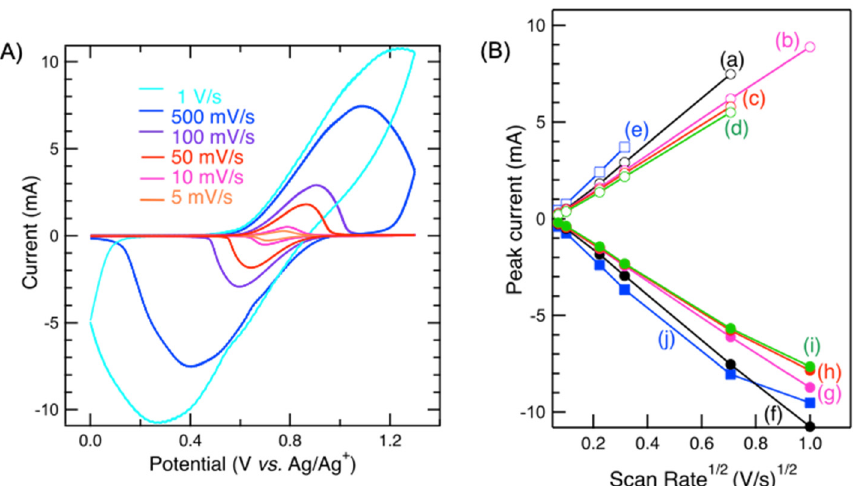
Figure 5. ( A ) CVs of polyFe/LIIm composite-3/0.1 film casted on ITO glass in the three-electrode system with diverse scan rates of 5, 10, 50, 100, and 500 mV/s and 1 V/s. ( B ) CV plots of the oxidation ( a – e ) and reduction ( f – j ) current as a function of the square root of the scan rates for polyFe/LIIm composites ( a , f ) 3/0.1, ( b , g ) 3/0.5, ( c , h ) 3/1, and ( d , i ) 3/5 and ( e , j ) reference polyFe films casted on ITO glass.